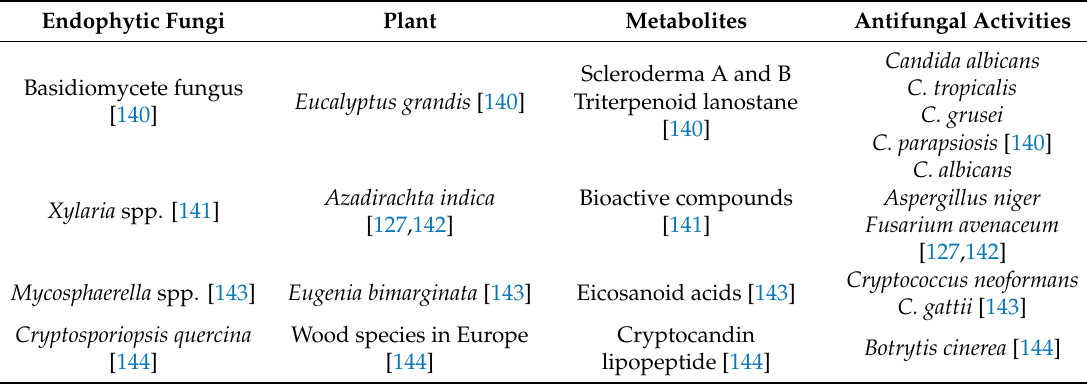
Production of secondary metabolites by endophytic fungi and their potential as antifungal